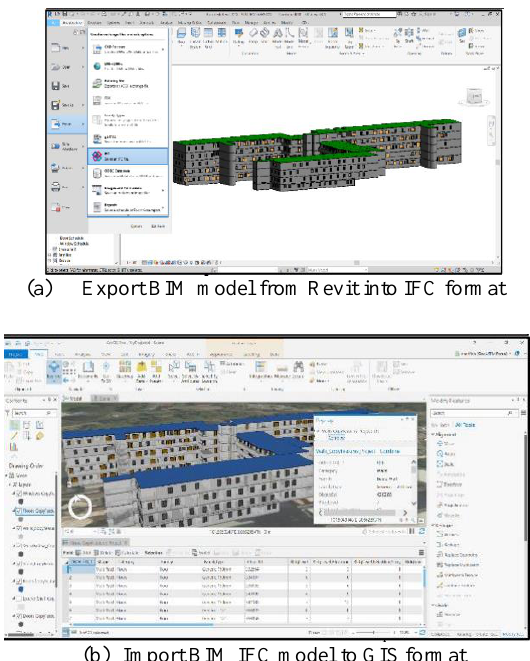
Figure 3. Example of BIM to GIS data conversion for 3D indoor GIS